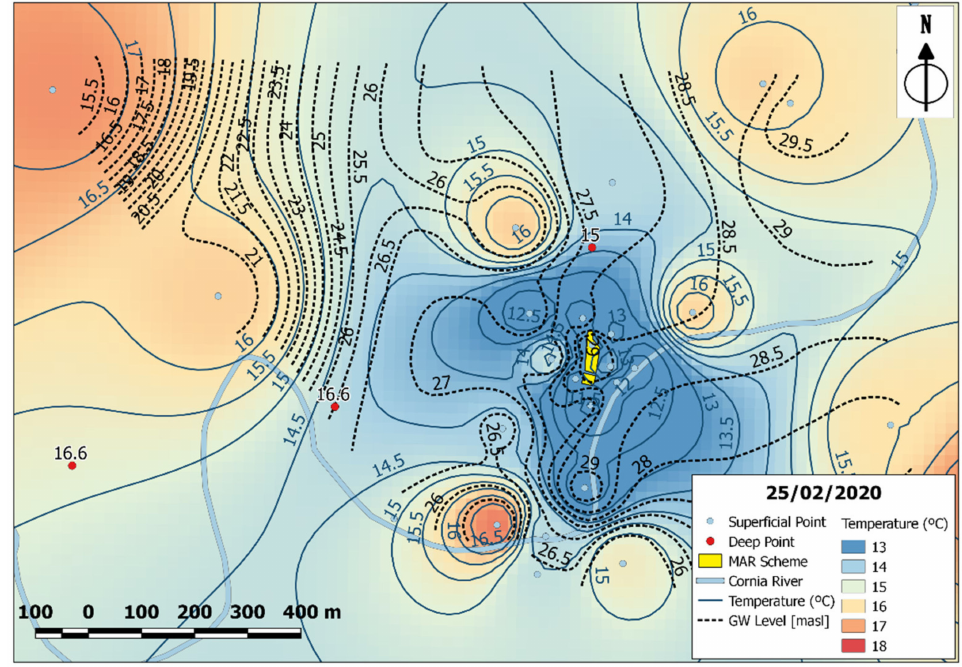
Figure 10. Groundwater temperature distribution after 14 days of the restart of MAR